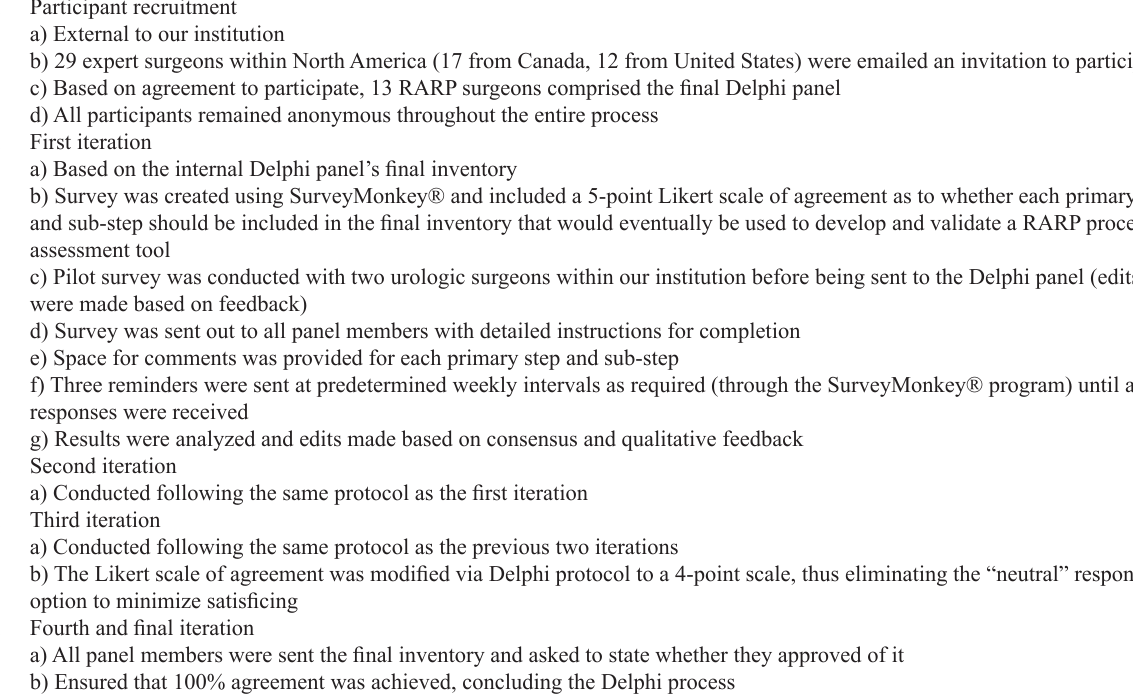
figure 3 - Outline of the Delphi